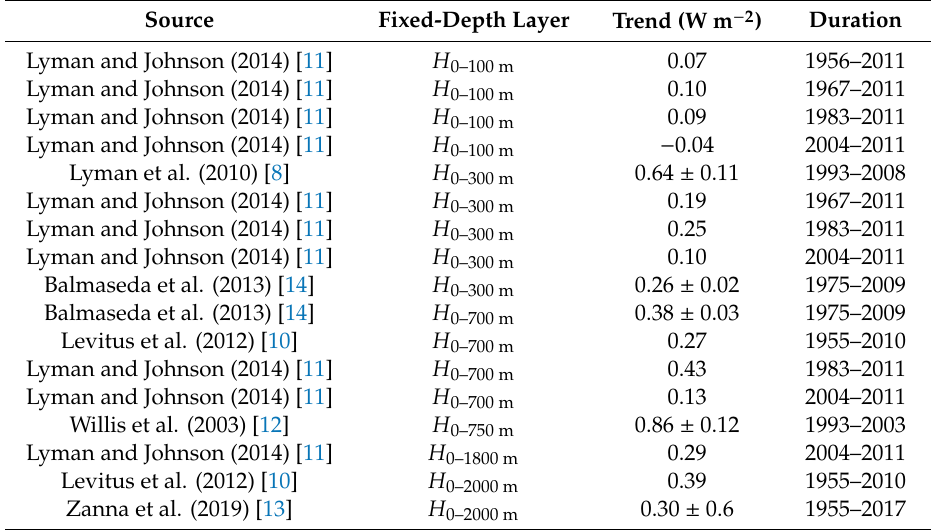
Table 1. Several reported trends (warming rate) of fixed depth ocean heat content